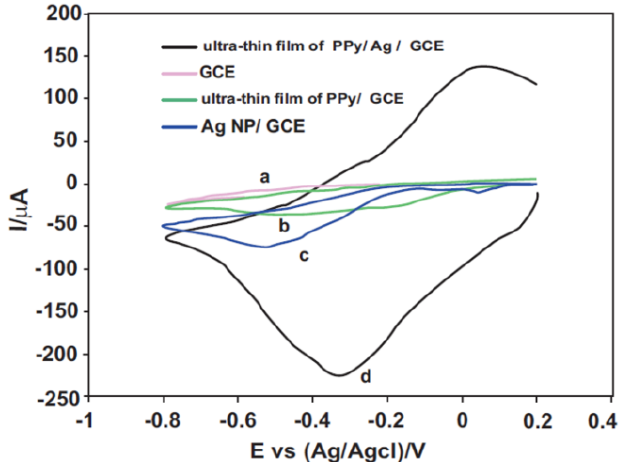
Figure 27. ( a ) CVs of a bare GCE, ( b ) UTPNSs/GCE and ( c ) Ag-UTPNSs/GCE in 0.2 M PBS solution at a pH of 6.5 in the presence of 1.0 mM H 2 O 2 using a scan rate 20 mV s − 1 . (Reproduced with permission from [130], Copyright Elsevier 2012).